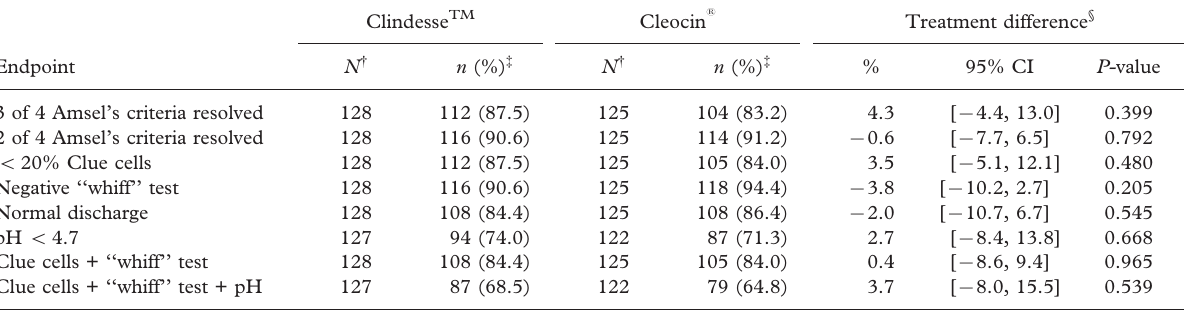
Clindesse TM Cleocin